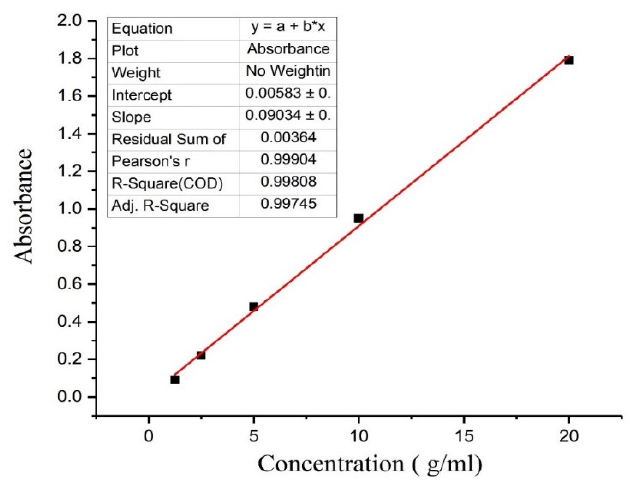
Figure 2. Standard curve of ceftizoxime.